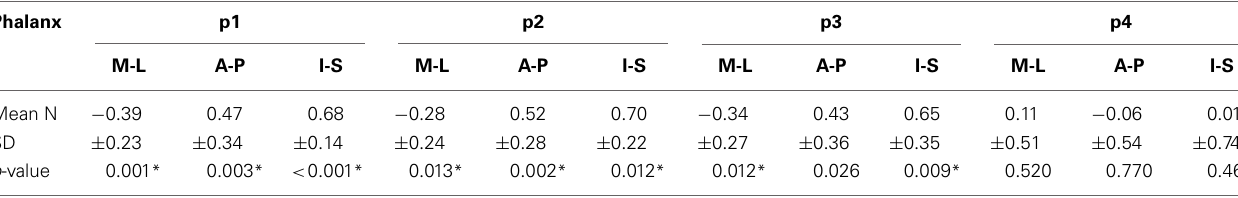
Table 4 | Across-digit direction consistency.